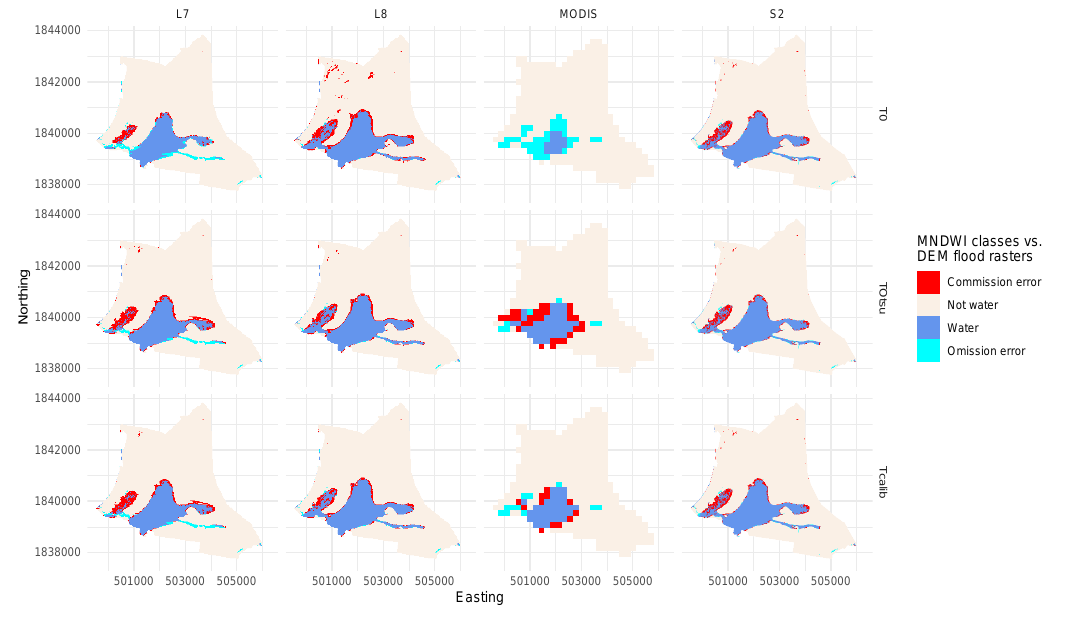
Figure 8. MNDWI classifications from four sensors based on three thresholding methods during a low flood, September 2017.